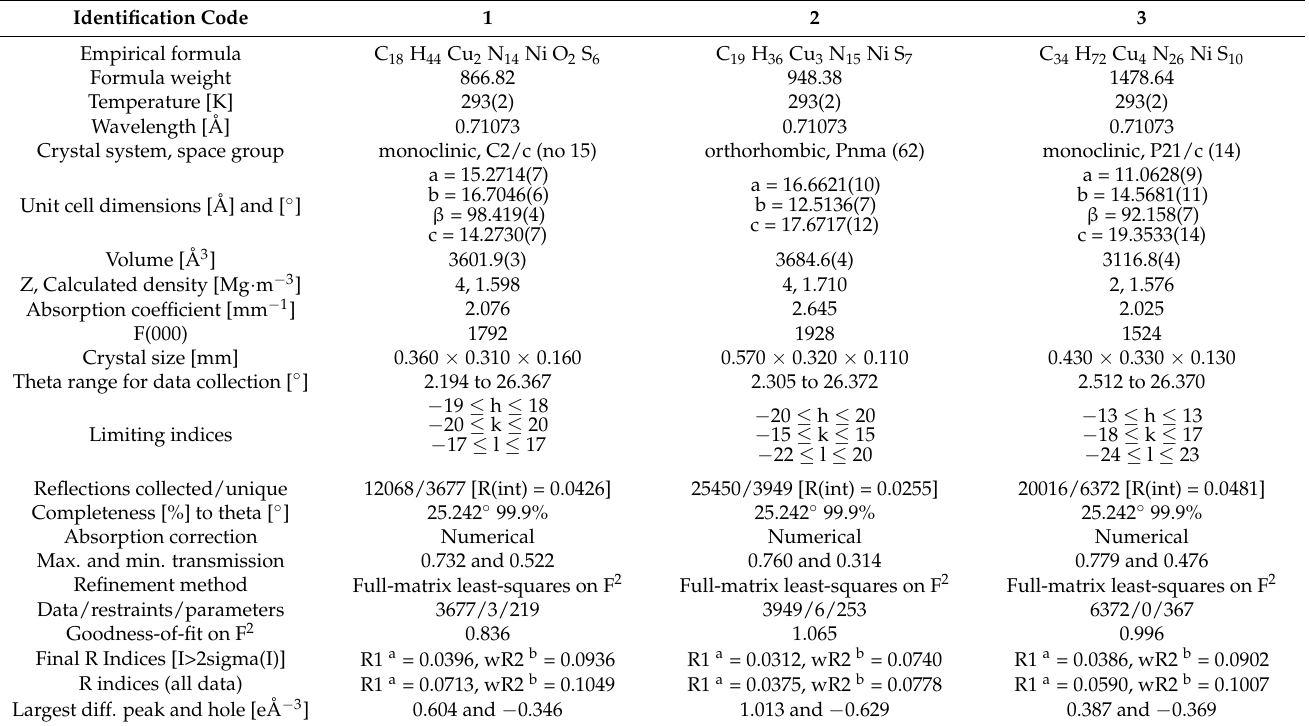
Table 1. Crystal data and structure refinement for 1 , 2 and 3